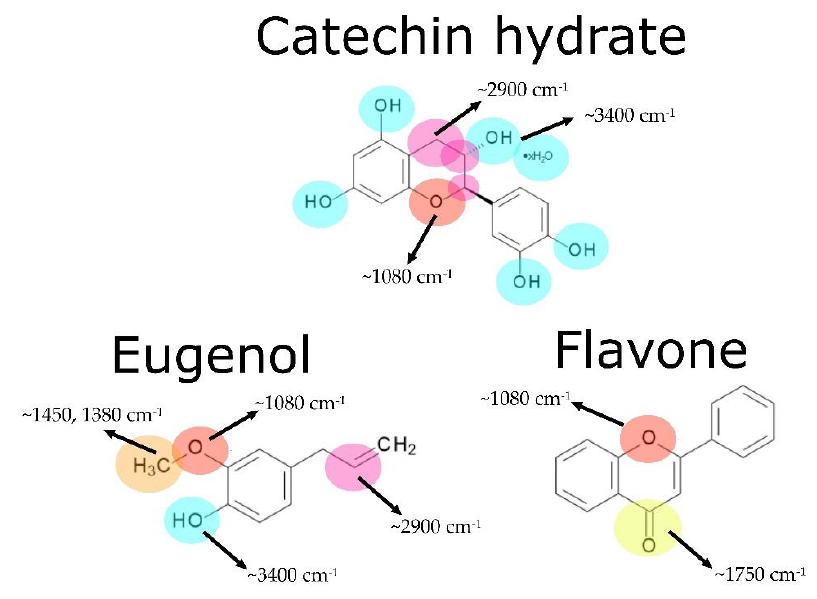
Figure 6. Absorption bands assigned to the chemical groups (bonds) that occur in the natural anti- oxidants: catechin hydrate, eugenol and flavone.